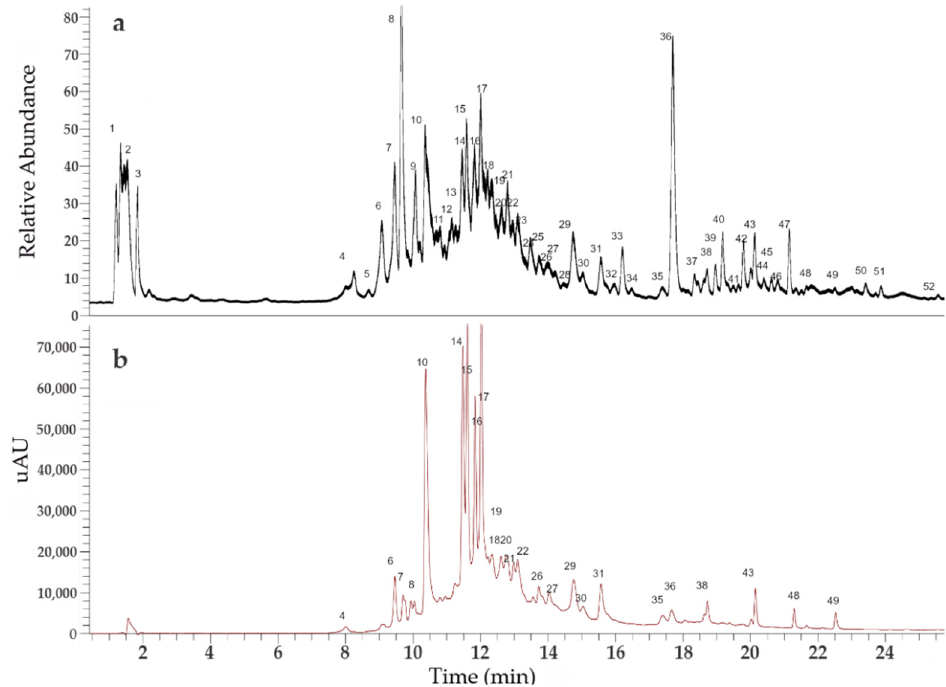
Figure 5. UHPLC chromatograms of Ta: ( a ) The total Ion Current (TIC) chromatogram and ( b ) the UV-vis chromatogram at 280 nm.